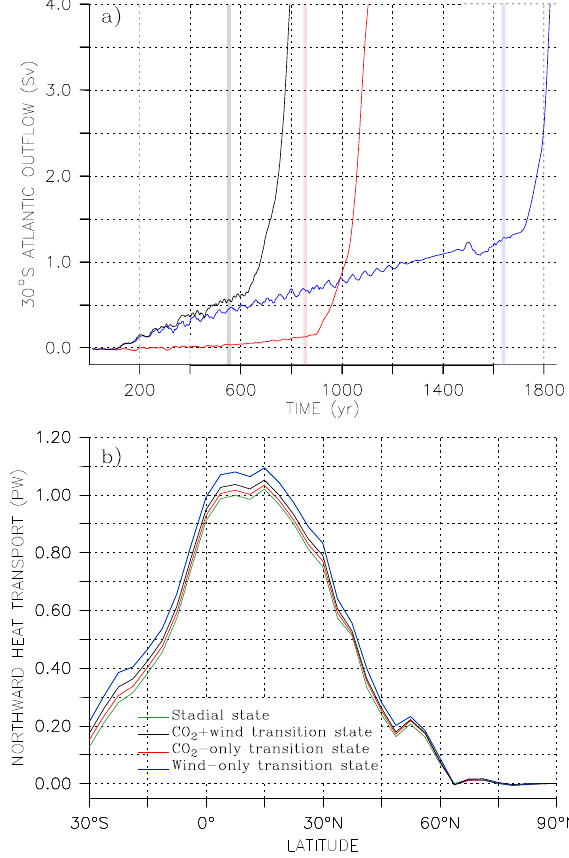
Fig. 9. (a) Evolution of AMOC outflow at 30 ◦ S in Sv for the CO 2 -plus-wind simulation (black), CO 2 -only (red) and wind-only (blue) forced experiments; (b) northward oceanic heat transport (0– 1000m depth) in PW for the stadial state (green) and transition stages for the CO 2 -plus-wind (black), CO 2 -only (red) and wind- only (blue) forced experiments. Black, red and blue shaded bars indicate the transition stage for the simulation combining CO 2 and wind forcings, the CO 2 -only run and the wind-only experiment, re-